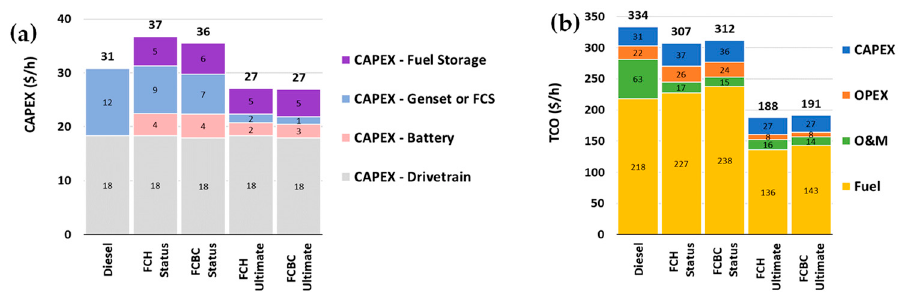
Figure 9. Total cost of ownership of the diesel and fuel cell hybrid platforms is USD 3.25/gal for diesel, USD 5/kg-H 2 for the status technologies, and USD 3/kg-H 2 for the ultimate technologies. The TCO is dominated by fuel costs and is more aptly described by the breakeven cost of H 2 relative to diesel for TCO parity: ( a ) CAPEX; ( b ) TCO